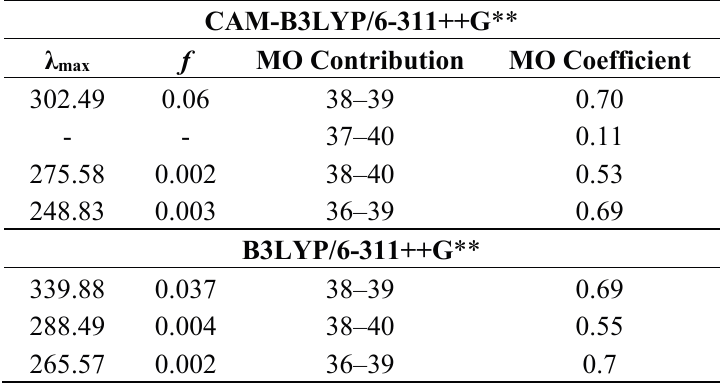
Figure 3. Relative energy and bond lengths for the 8HQ, 8-OateQ-syn and 8-OateQ-anti using B3LYP and CAM-B3LYP at 6-311++G** basis set. Table 2. TD-DFT spectral data of electronic transitions for 8HQ using CAM-B3LYP and B3LYP functionals at 6-311++G** basis